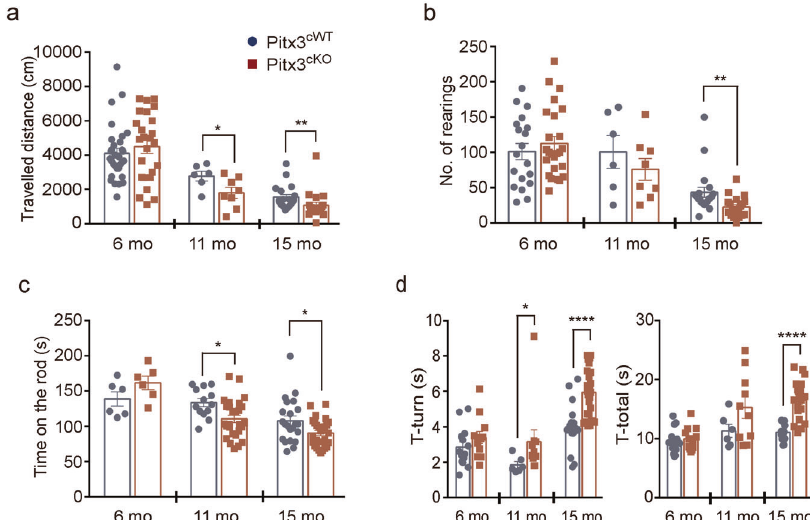
Fig. 4 Motor behavior in Pitx3 cKO mice. a Total traveled distance and b the number of rearings were performed in open- fi eld tests ( N = 6 – 31 mice per genotype). Unpaired t -test, * p = 0.0471 (total distance at 11 months of the age); Mann – Whitney test, ** p = 0.0011 (total distance at 15 months old); and ** p = 0.0011 (rearings at 15 months old). c The latency to fall from rotarod for 6-, 11-, and 15-month-old Pitx3 cWT and Pitx3 cKO mice ( N = 6 – 27 mice per genotype). Unpaired t -test, * p = 0.0107 (11 months old); and * p = 0.0206 (15 months old). d The turning time and total task time for 6-, 11-, and 15-month-old Pitx3 cWT and Pitx3 cKO mice in pole tests ( N = 6 – 27 mice per genotype). Unpaired t -test, **** p < 0.0001 (turning time at 15 months old); and **** p < 0.0001 (total time at 15 months old); Mann – Whitney test, * p = 0.016 (turning time at 11 months